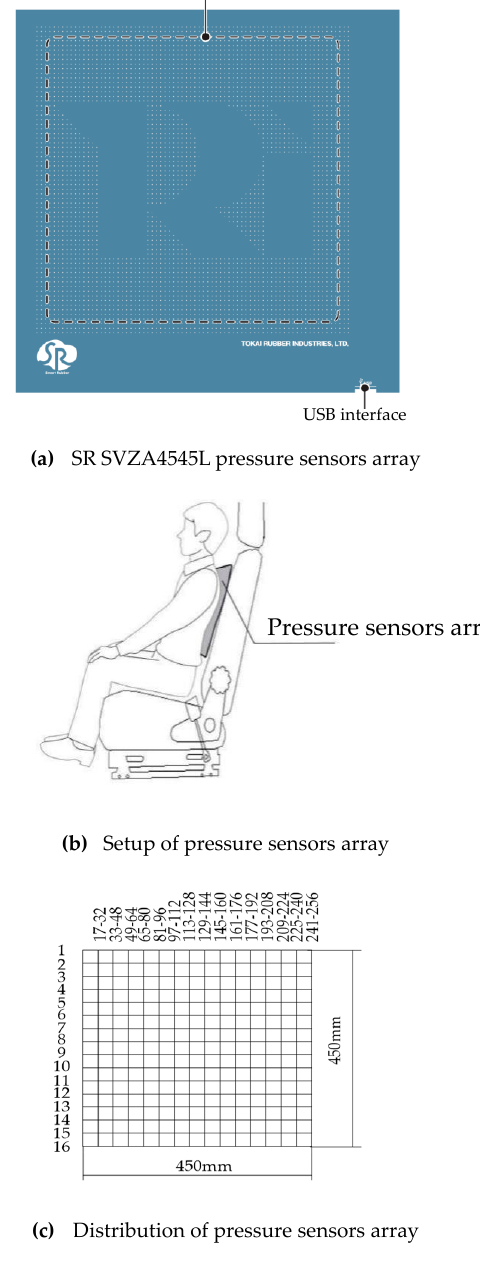
Figure 3. Schematic of pressure sensors setup.